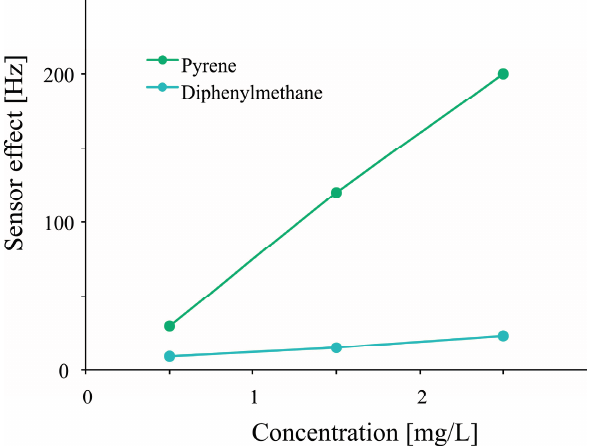
Figure 3. Sensor effects as a function of β -estradiol concentrations after incorporating porogens (pyrene, diphenylmethane) in molecular imprinted polyurethane during synthesis.